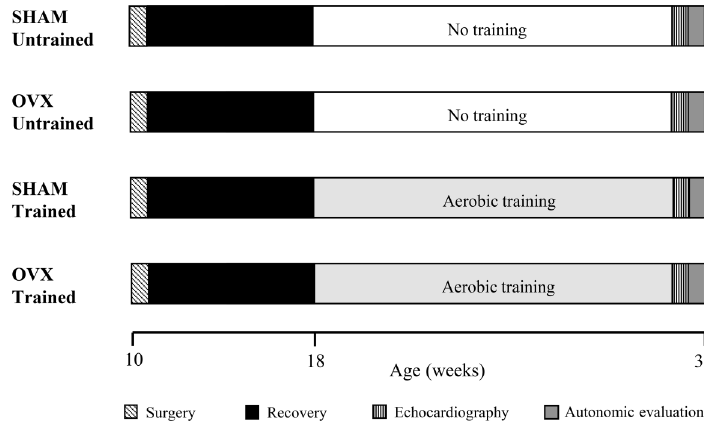
Figure 1. Schematic representation of the experimental timeline of SHAM and ovariectomized (OVX) groups.